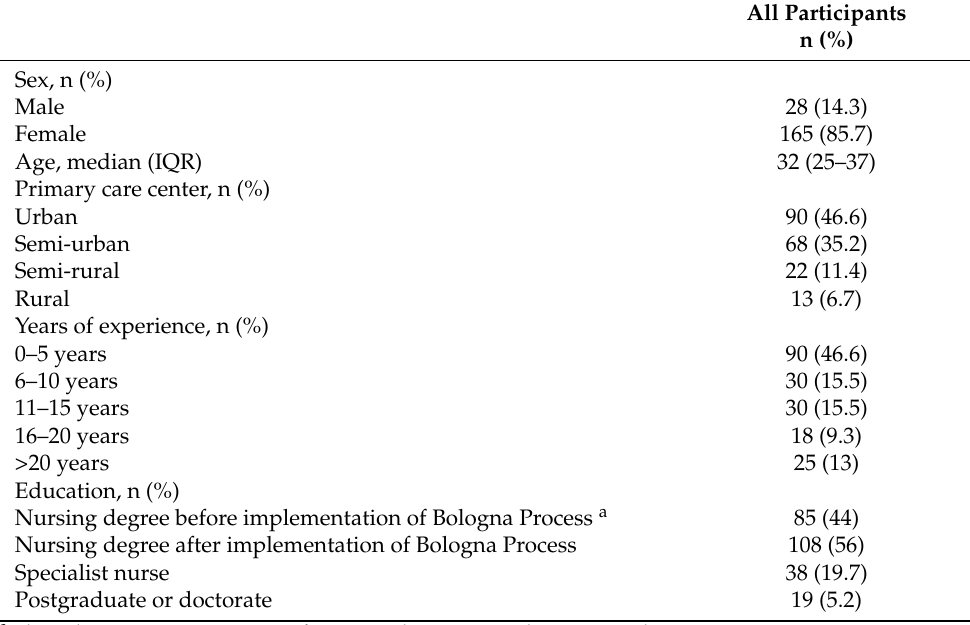
Table 1. Sociodemographic characteristics of the study’s participants ( n = 193).